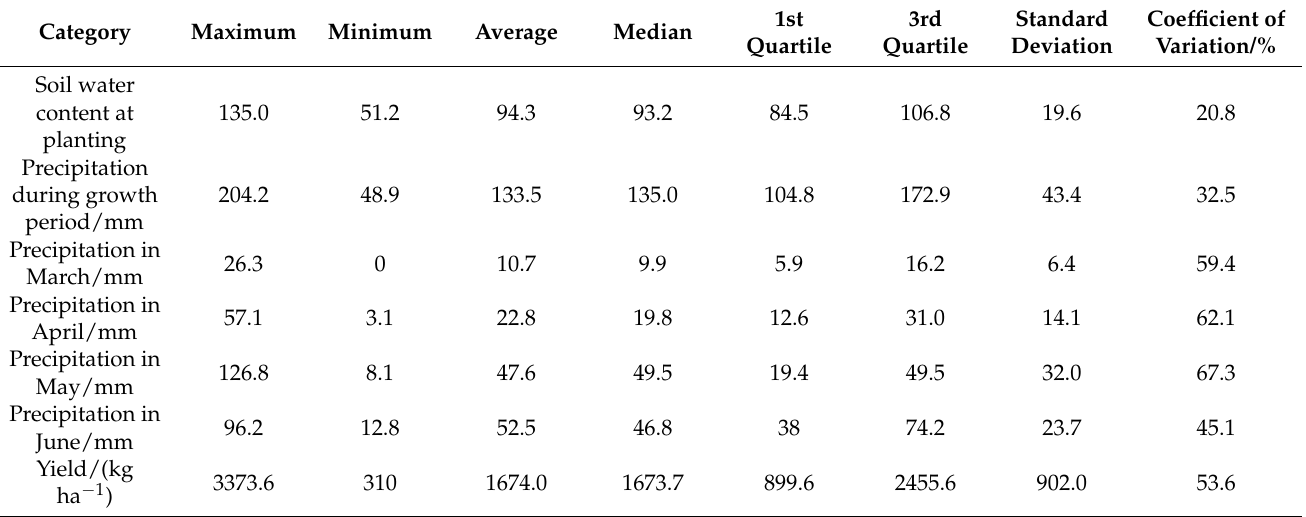
Table 1. Statistics of soil water content at planting, precipitation during each month and main growth periods, and yields for spring wheat during the growth period from 1987 to 2011 (sample number n =